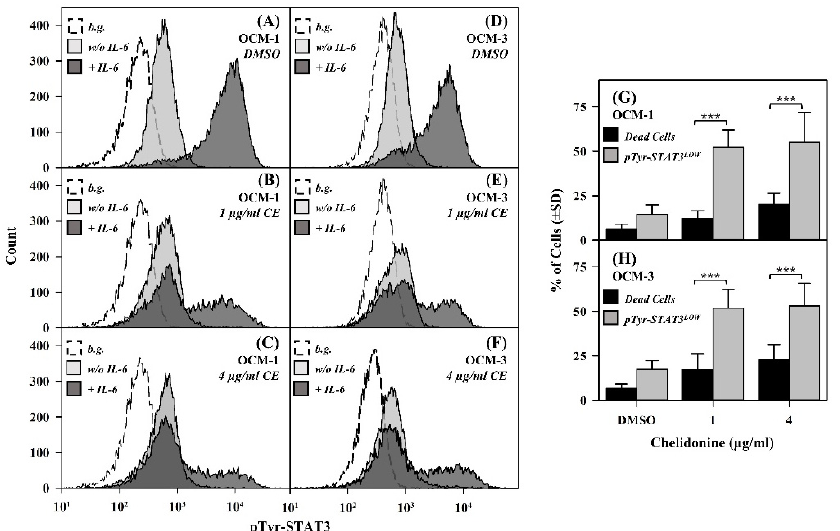
Figure 1. IL-6 induced tyrosine phosphorylation of STAT3 is abolished completely by chelidonine in a significant portion of OCM-1 and OCM-3 human uveal melanoma cells. ( A – F ) Representative flow cytometric intensity histograms demonstrate cell-by-cell distribution of pTyr-STAT3 levels in DMSO- and chelidonine-treated cells. Dark and light grey histograms correspond to IL-6-stimulated and unstimulated cells, respectively, whereas the empty histograms represent unlabeled cells (back- ground). ( G , H ) Bar charts demonstrate the percentage of IL-6 nonresponsive cells and that of dead